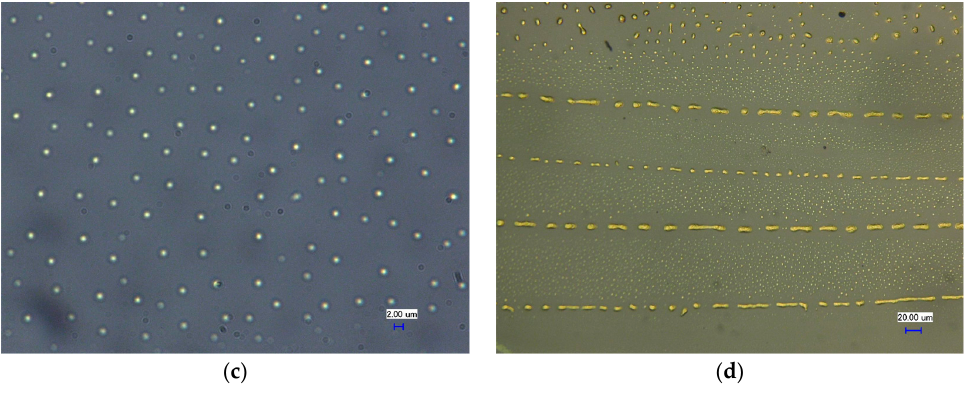
Figure 6. ( a ) Diagram depicting the various morphologies of RR-P3HT patterns formed by evaporative self-assembly under flexible geometric confinement. Optical microscope images of RR-P3HT patterns formed by evaporation under flexible geometric confinement: ( b ) regular dots, ( c ) irregularly distributed dots in between the stripes as seen in ( d ) incomplete stripes. Table 2. Widths and periodicities of RR-P3HT microstructure distant from the central region using solution of low concentration of 1 wt %. Distance/mm Width/ μ m Periodicity/ μ m